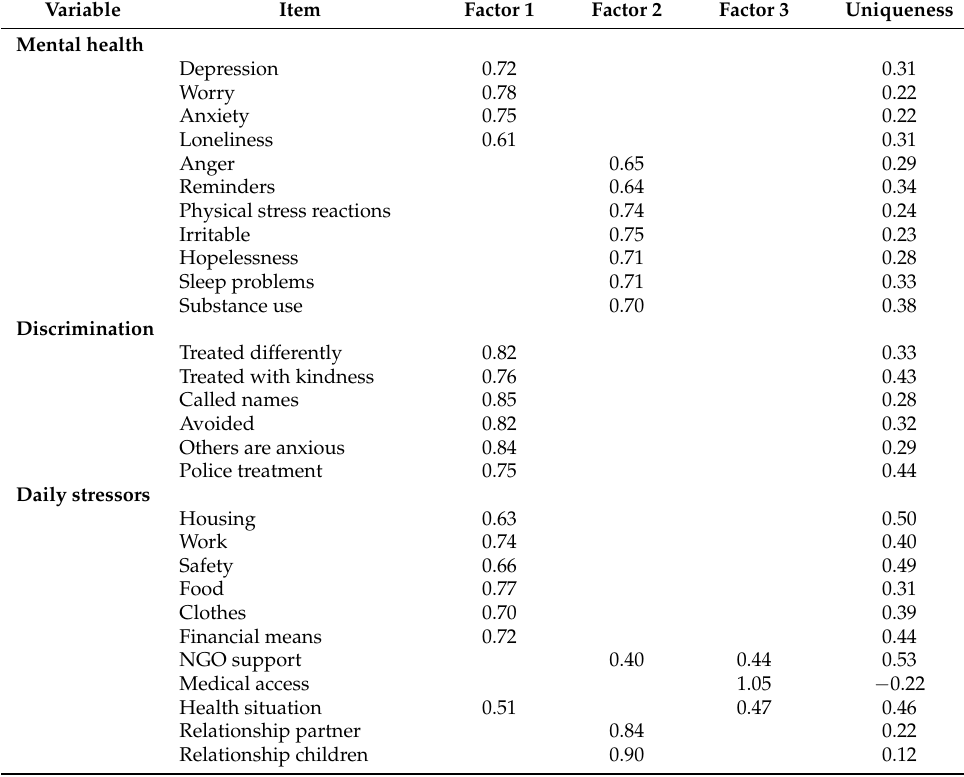
Table 5. Factor loadings, varimax